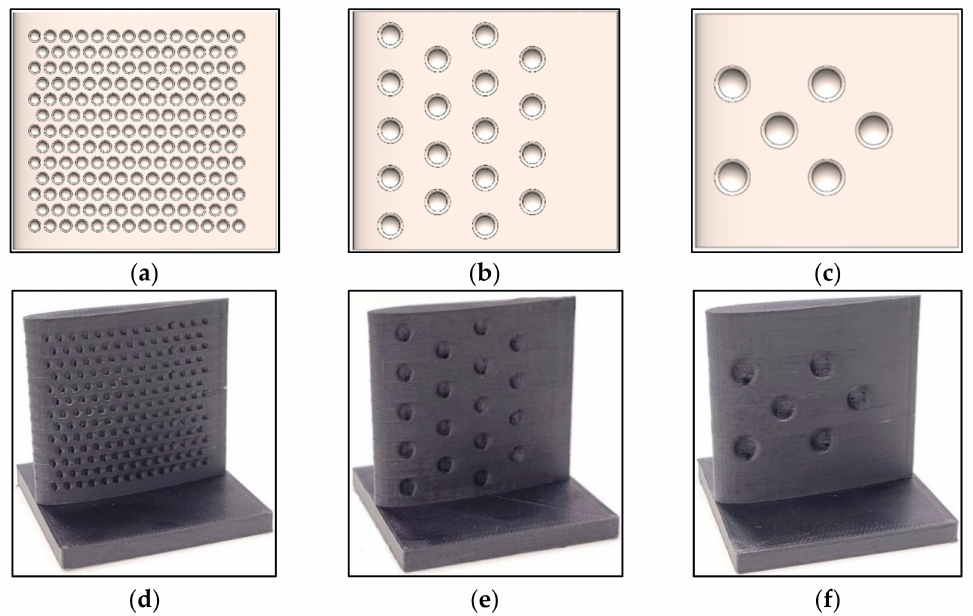
Figure 4. ( a ) HX 1–2 mm dimples; ( b ) HX 2–4 mm dimples; ( c ) HX 3–6 mm dimples; ( d ) 3D-printed